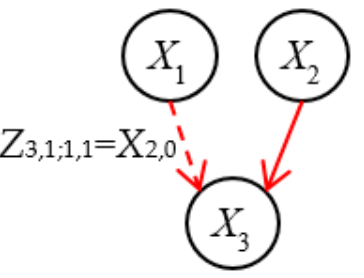
Figure 4. Example of a conditional case.